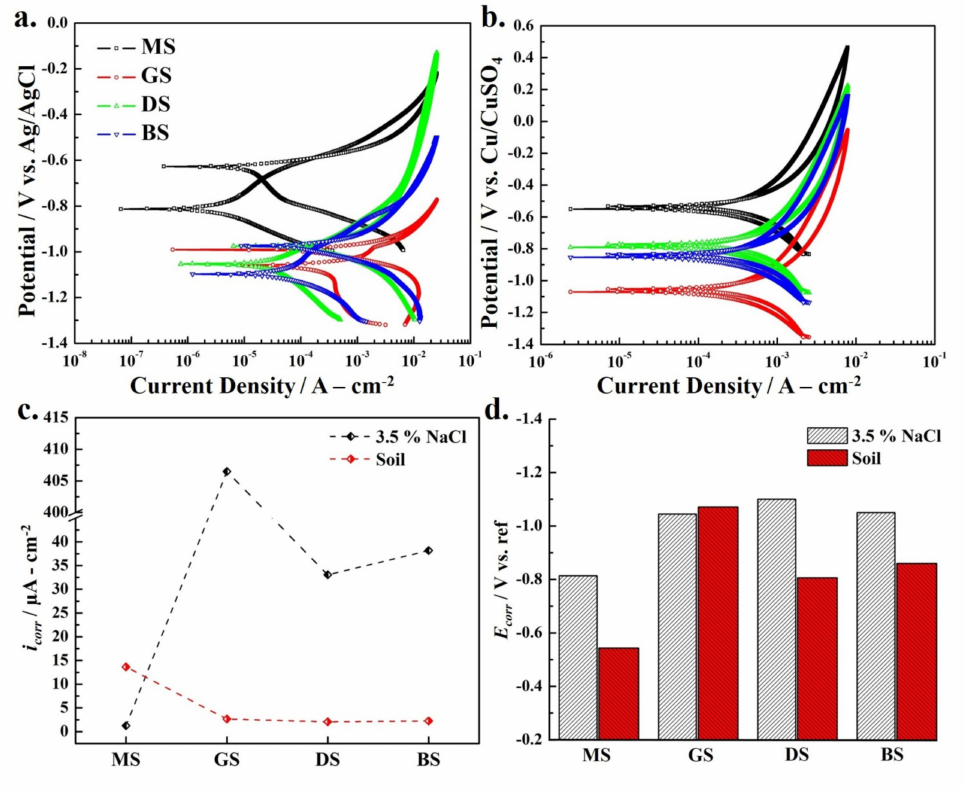
Figure 6. Cyclic Polarization ( a ) 3.5% NaCl environment ( b ) soil environment (c) corrosion current profile and ( d ) corro- sion